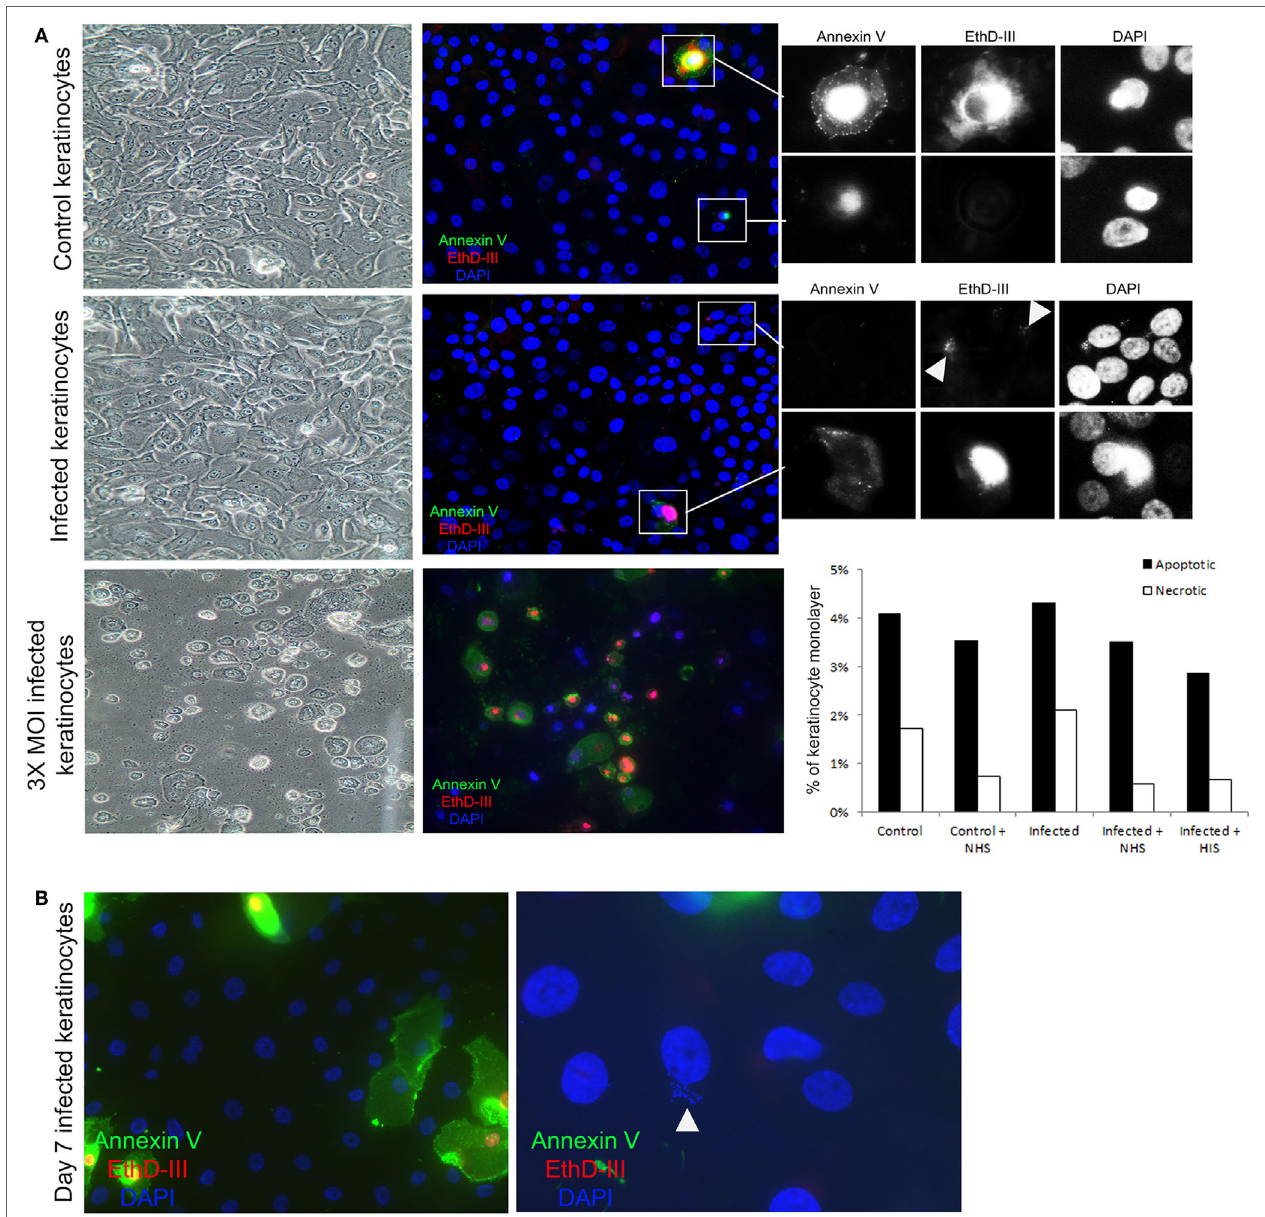
FigUre 5 | Complement activation takes place on viable keratinocytes. (a) Immunofluorescence microscopy of control and infected keratinocytes shows no significant difference in apoptotic cells stained with Annexin V (green), and necrotic cells with EthD-III (red). A representative experiment was quantified in the bar graph to the right, treatment with normal human serum (NHS)/HIS did not show any significant difference. Insets show a close up of apoptotic and necrotic cells. Arrow heads point to Staphylococcus aureus DNA stained with EthD-III. Light microscopy shows intact monolayers of control and infected primary keratinocytes. A higher multiplicity of infection (MOI) induced extensive apoptosis and necrosis in the monolayers and was used as a positive control. (B) Keratinocytes infected for 7 days were found to harbor intracellular bacteria, both keratinocytes and bacteria (arrow head) shown in the image are thought to be viable since they did not stain for the apoptosis or necrosis